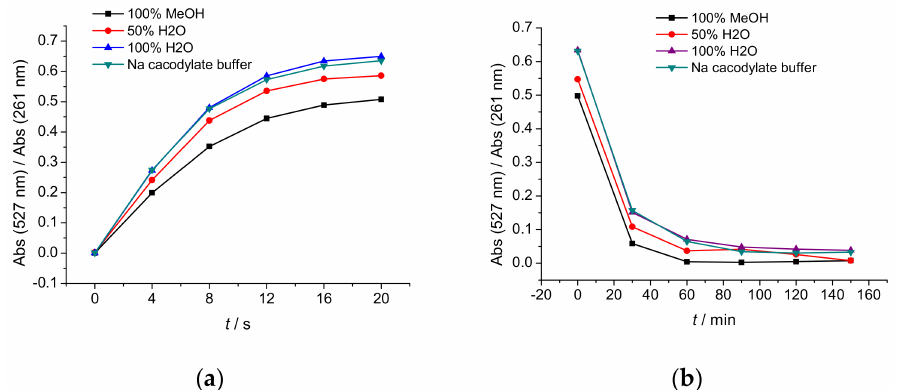
Figure 4. Measurements of DAE-NH 2 ( c = 1.0 × 10 − 4 M) at MeOH, 50% H 2 O in MeOH, H 2 O and Na cacodylate buffer (pH = 7.0, I = 0.05 M) showing A 527 /A 261 ratios during ( a ) irradiation with 64 W, range 254–315 nm lamps, as a function of irradiation time ( t tot . = 20.00 s), ( b ) irradiation with 64 W, range 400–700 nm lamps, as a function of irradiation time ( t tot . = 150.00 min).